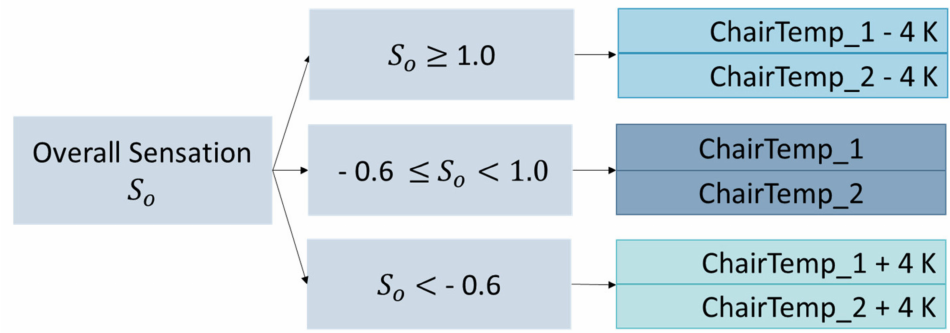
Figure 12. Control logic of the office chair with heating and cooling function: ChairTemp_1 considers the backrest and addresses the back; ChairTemp_2 considers the seat and addresses the pelvis and